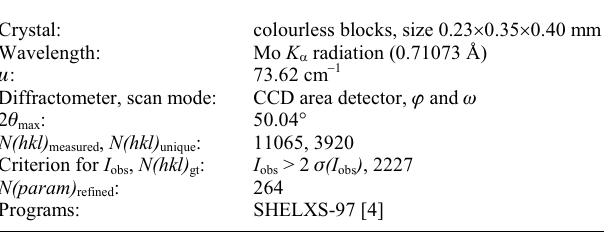
Table 1. Data collection and handling.